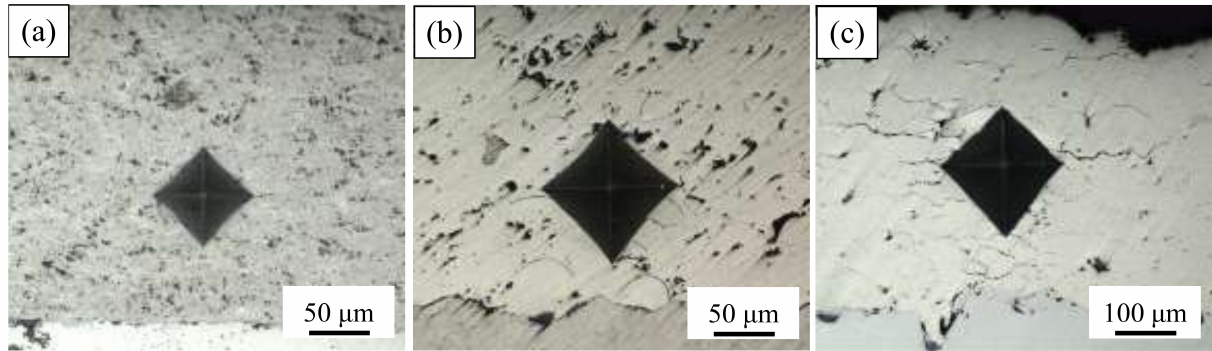
Figure 6. Indentation morphology of the coatings: ( a ) WC-10Ni, ( b ) Ni45, ( c )